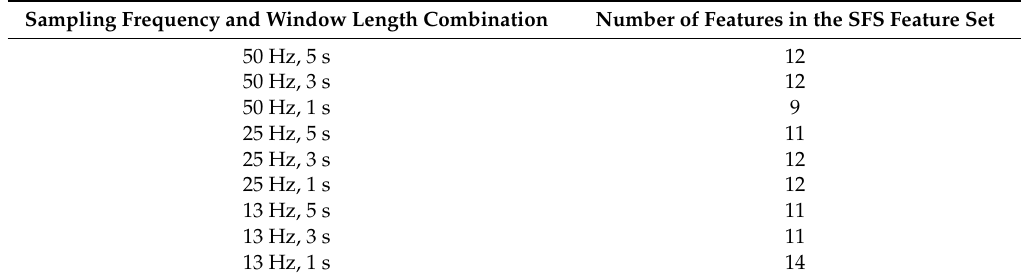
Table 3. Number of features in sequential feature selection (SFS) feature sets with di ff erent sampling frequencies and window lengths.